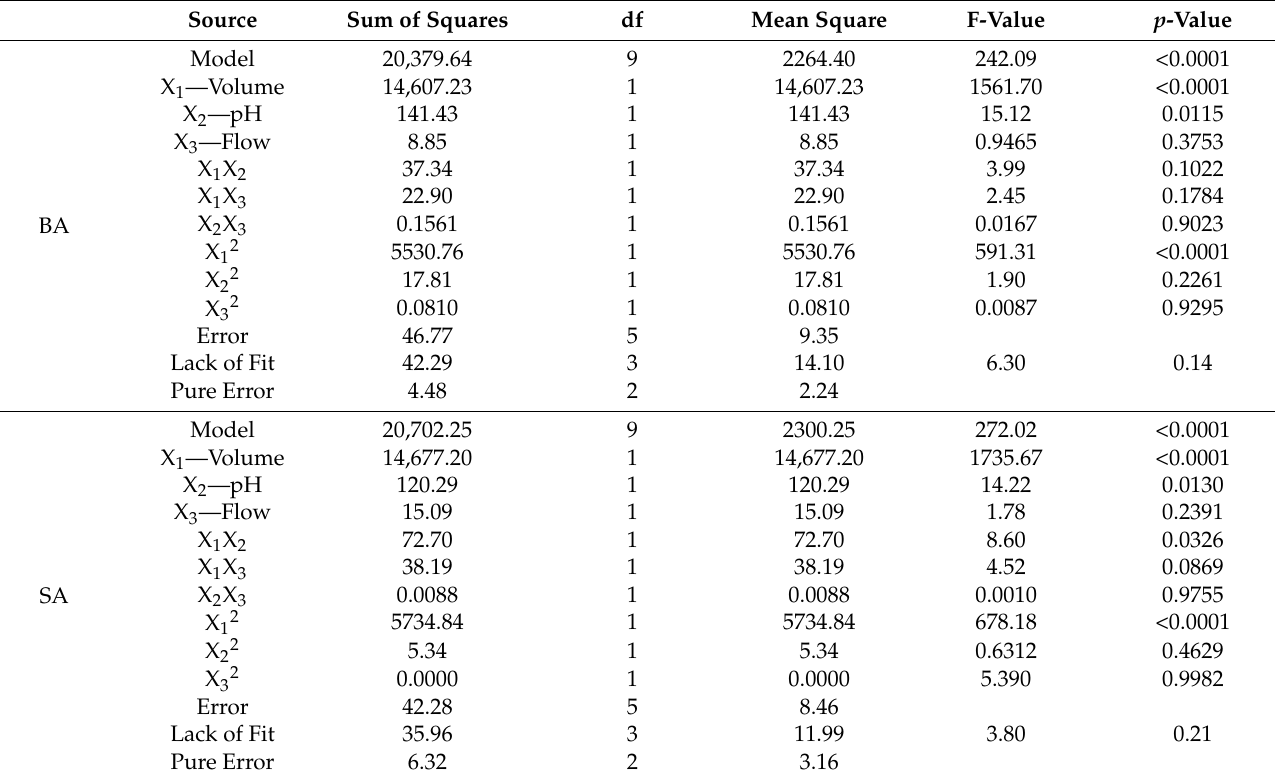
Table 4. ANOVA analysis of the percolation